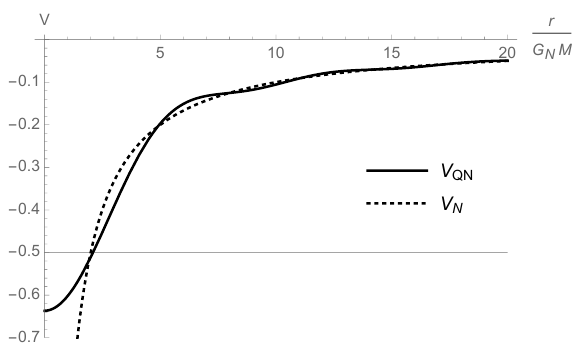
Figure 2. Quantum corrected potential V QN in Equation (18) (solid line) compared to V N in Equation (13) (dashed line) for R N cation of the horizon where V N = V QN = −